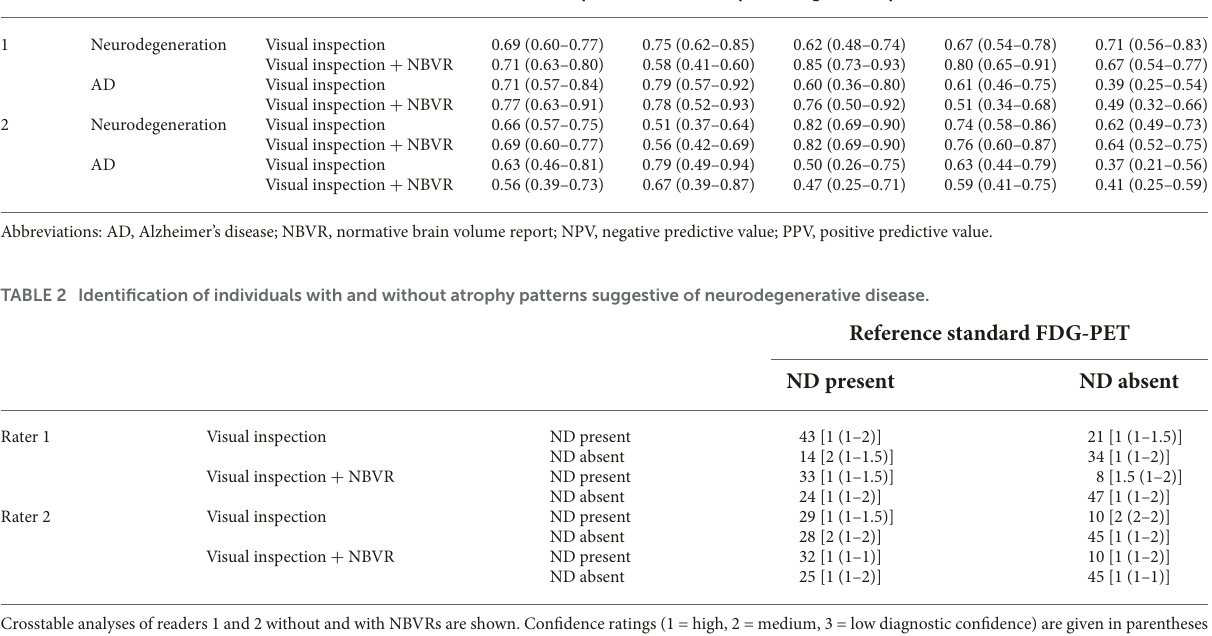
with neurodegenerative disease using NBVRs are shown in Figure 2 .